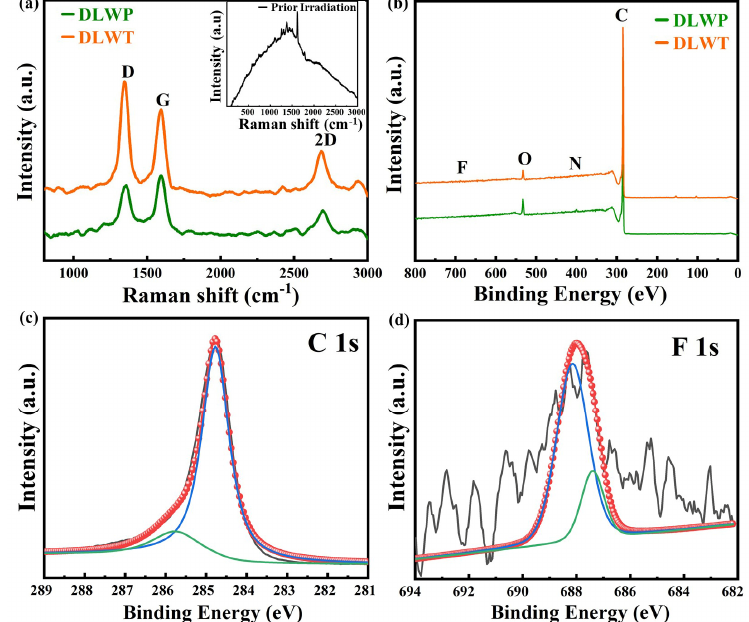
Figure 3. ( a ) the Raman spectra of the porous carbon materials prepared by DLW on transparent PI and non-transparent PI (DLWT and DLWP) (Embedded graph is the Raman spectra of transparent polyimide film (PI)); ( b ) the X-ray photoelectron spectroscopy (XPS) spectra; ( c ) the high-resolution C 1s of DLWT; ( d ) the high-resolution F 1s of DLWT. 1s of DLWT; ( d ) the high-resolution F 1s of